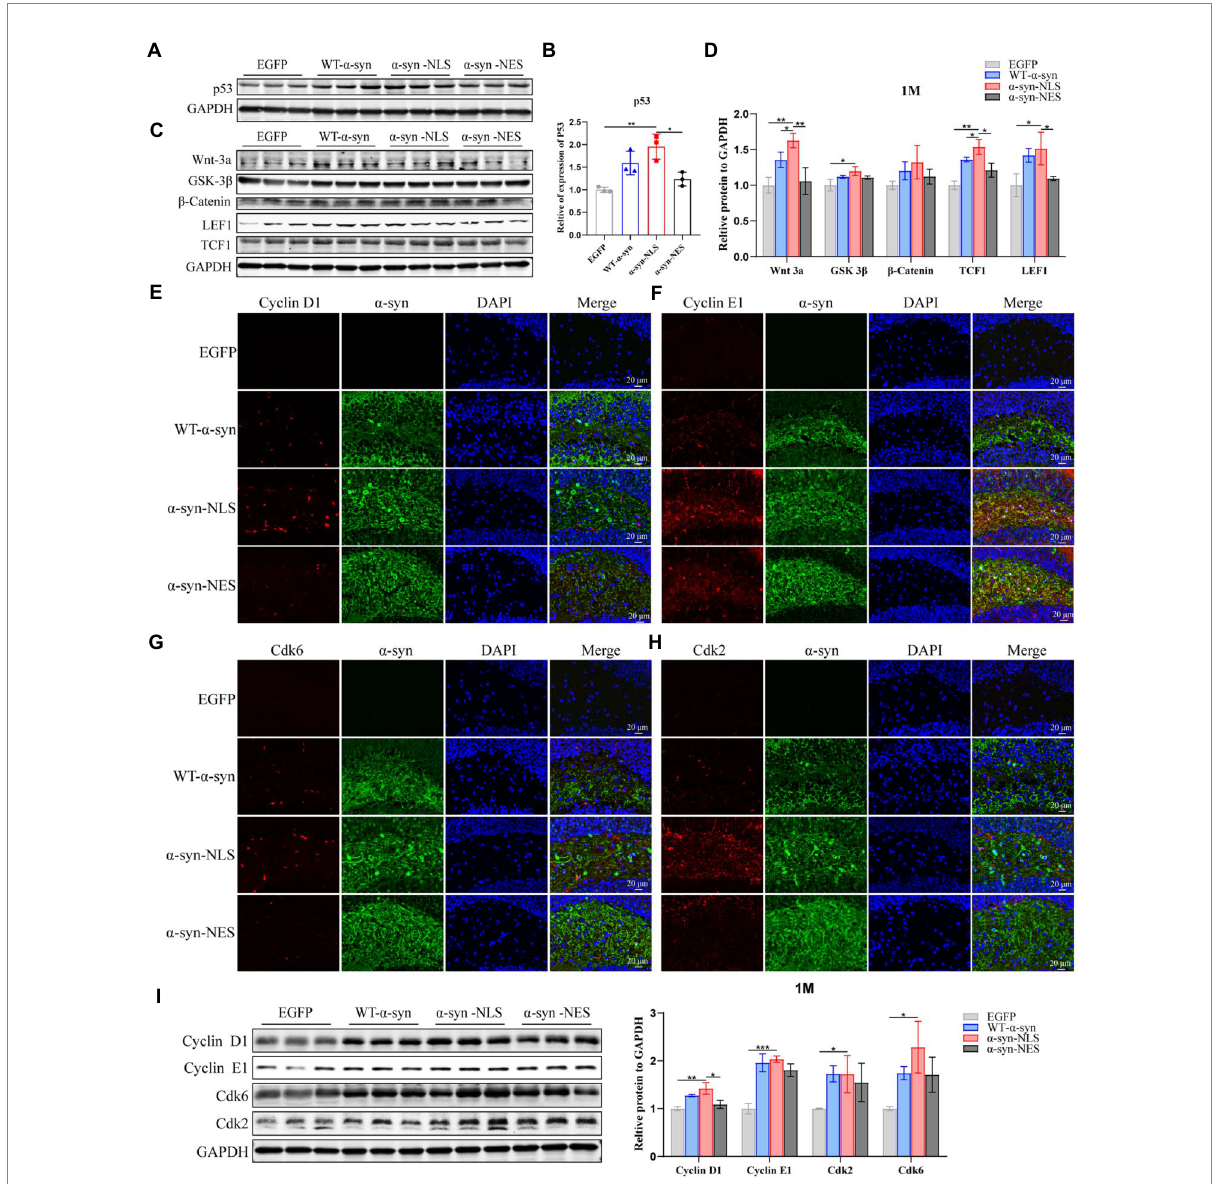
FIGURE 4 DNA damage activates cell cycle G1/S checkpoints, prompting neuronal cell cycle reentry. (A,B) Western blot and relative level analysis of p53 protein after 1 month of virus injection ( n = 3). (C) Western blot of the hippocampus tissues of mice with antibodies to Wnt-3a, glycogen synthase kinase-3beta (GSK-3 β ), β -Catenin, LEF1, and TCF1 ( n = 3). (D) Relative levels of proteins (ratio to GAPDH) in western blot are presented ( n = 3). (E–H) The expression levels of cell cycle S phase proteins CDK2, CDK6, Cyclin D1, and Cyclin E1 were detected by immunofluorescence. (I) Western blot with CDK2, CDK6, Cyclin D1, and Cyclin E1 antibodies and their relative levels ( n = 3). * p < 0.05, ** p < 0.01, *** p <